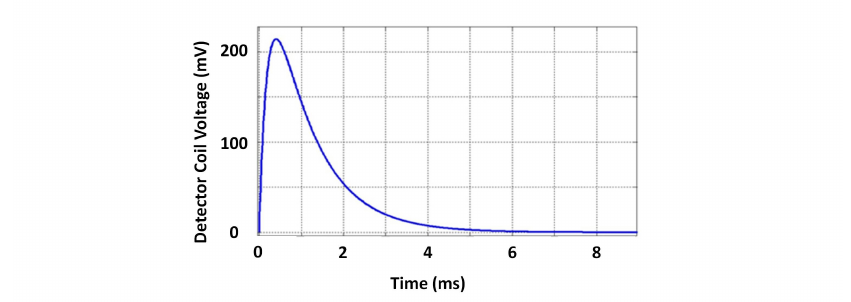
Figure 2. The typical shape of a PEC signal: induced voltage in the detector